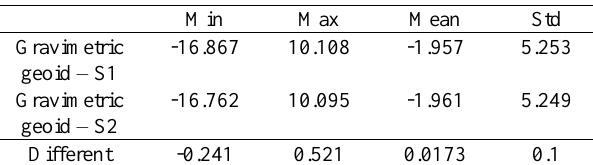
Table 3 Statistical analysis of gravimetric geoid (Unit: